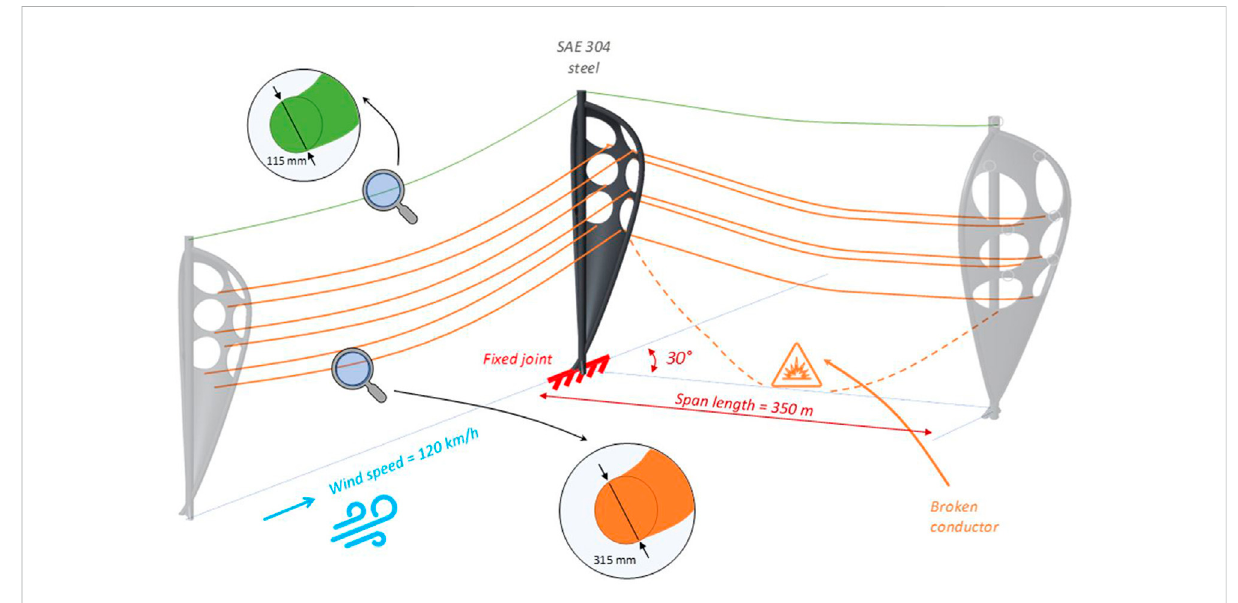
FIGURE 7 Graphical representation of the information used for the